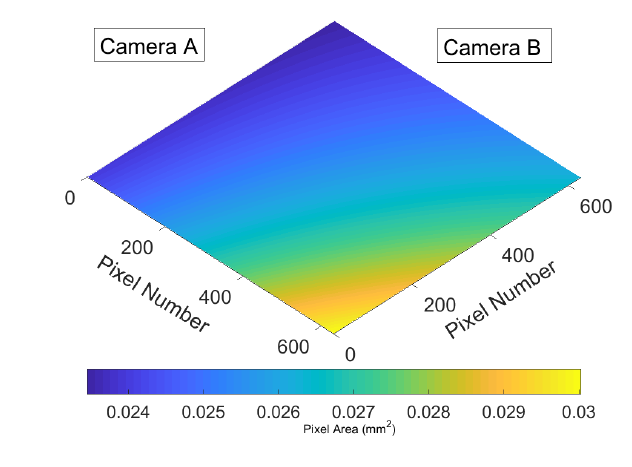
Figure 3. The effective area (in mm 2 ) of each pixel within the field of view for 2DVD SN074, as determined by using the measurements presented in Table 1. The geometry is shown to coincide with the orientation presented in Figure